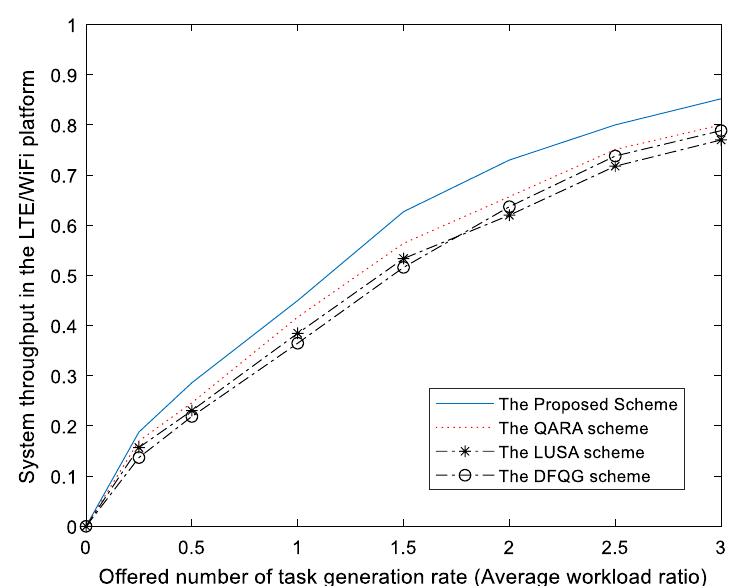
Fig. 3 LTE/WiFi system throughput. From the viewpoint of system operator, it is a key performance evaluation factor